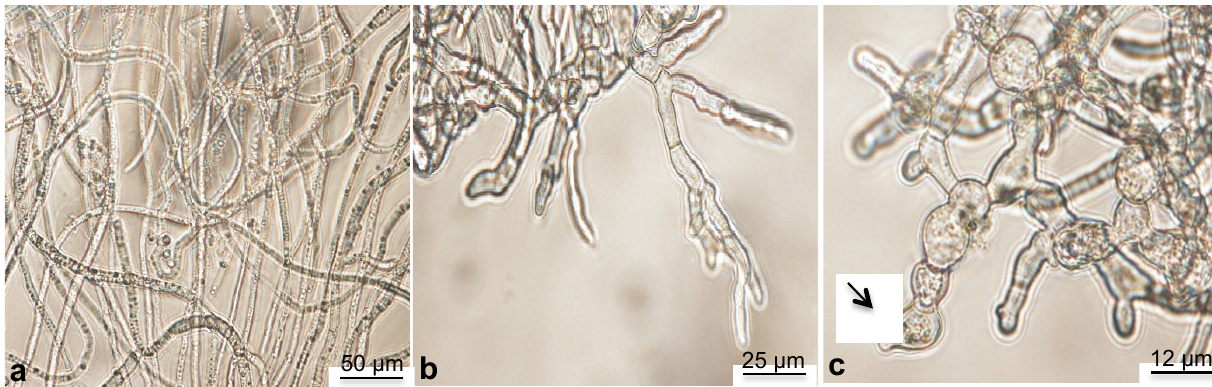
Figure 3. Representative photographs showing B. cinerea mycelial development ( a ) in the culture medium alone as control or ( b , c ) added by compounds 2 , 4 , 7 or 8 .